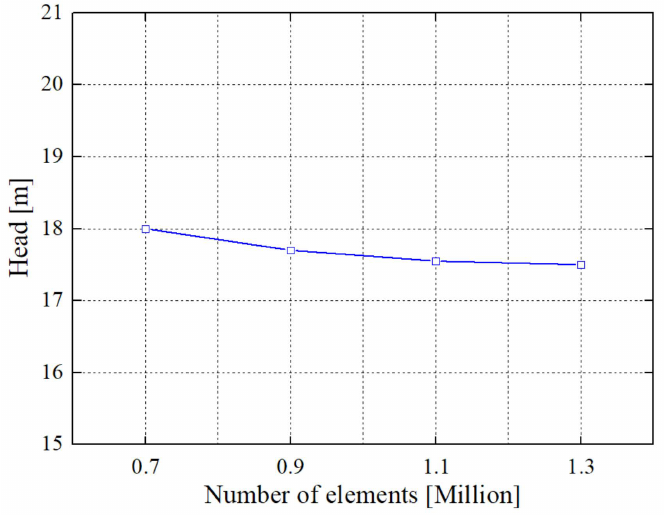
Figure 6. Mesh independence analysis.